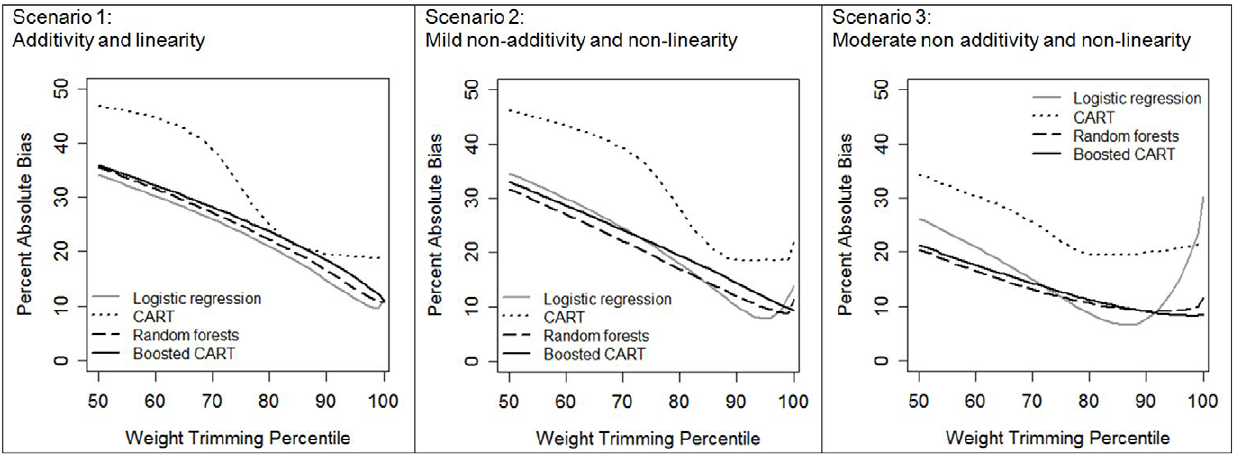
Figure 1. Average percent absolute bias in the estimate of treatment effect after propensity score weight trimming for 1000 simulated datasets of N=500, by propensity score estimation method and degree of complexity in the true propensity score model scenario. Scenario 1: additivity and linearity; Scenario 2: mild non-additivity and non-linearity; Scenario 3: moderate non-additivity and non-linearity. The 100th percentile of weight trimming indicates no trimming was applied.